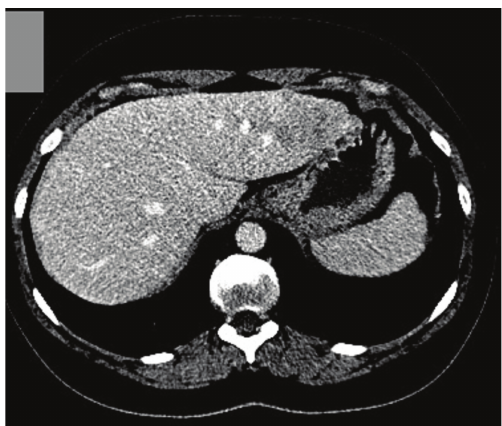
Figure 1: CT scan showing hypovascular lesion in left lobe of liver.